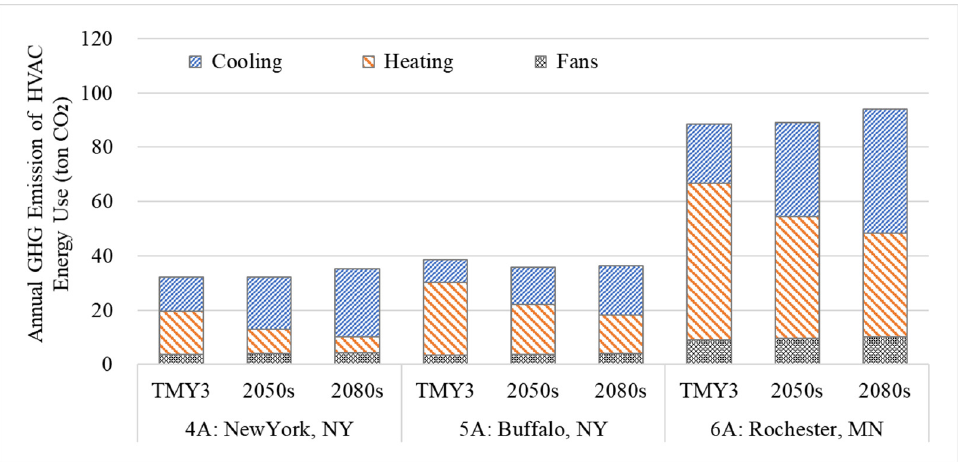
Figure 13. Annual GHG emission of baseline models by HVAC components.